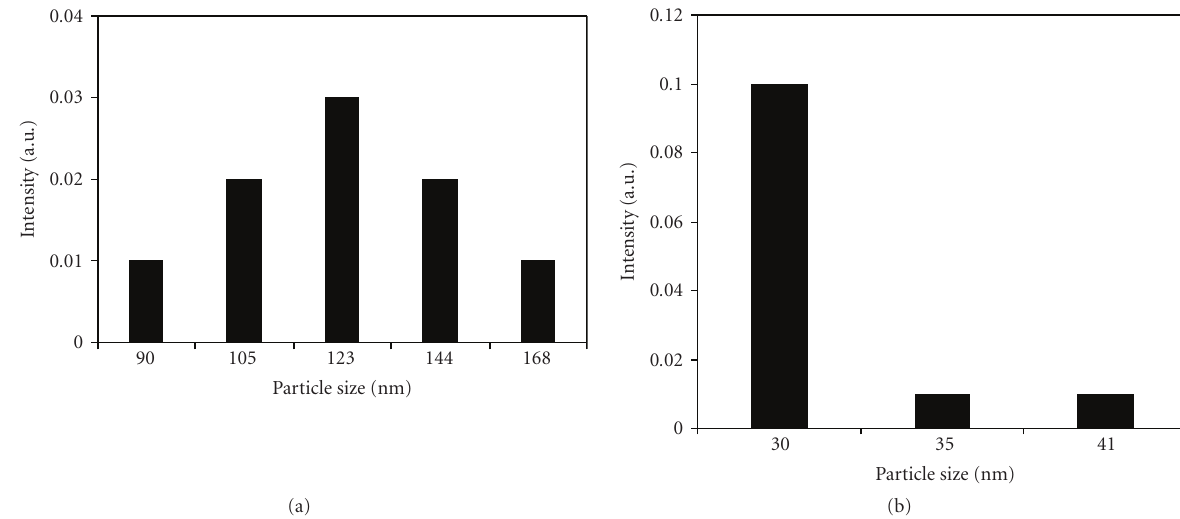
Figure 5: (a) Particle size distribution of CaCO 3 particles synthesized without orifice in the pipe (4% Ca(OH) 2 slurry, 5l/min CO 2 flow rate). (b) Particle size distribution of CaCO 3 particles synthesized using Hydrodynamic cavitation (2mm orifice, 4% Ca(OH) 2 slurry, 5l/min CO 2 flow rate).